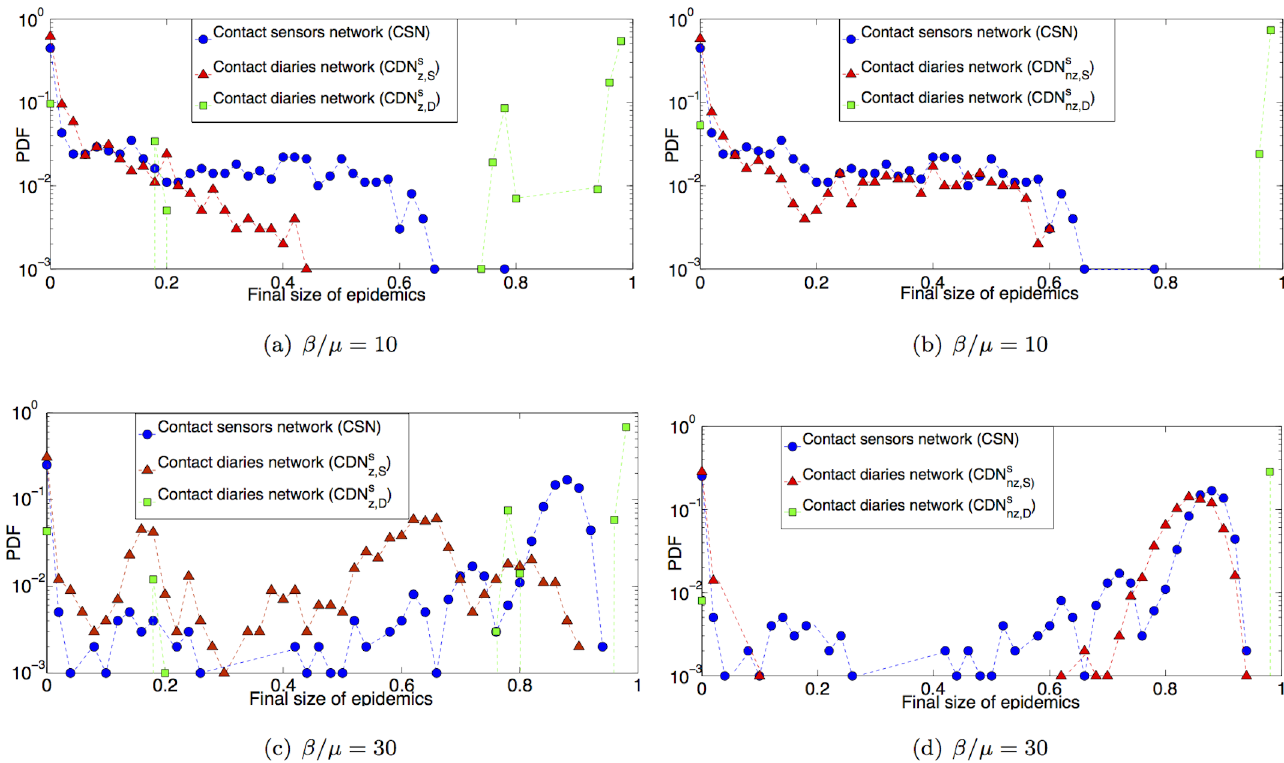
Fig 5. Distribution of final size of epidemics. 1000 SIR simulations performed on the contact sensors network (CSN) and the four surrogate contact diaries network with and without zeros in the contact matrix of link densities, and with durations extracted at random from the lists of values respectively reported by students and registered by sensors: (a), (c) CDN s random infected seed. β / μ 2 {10,